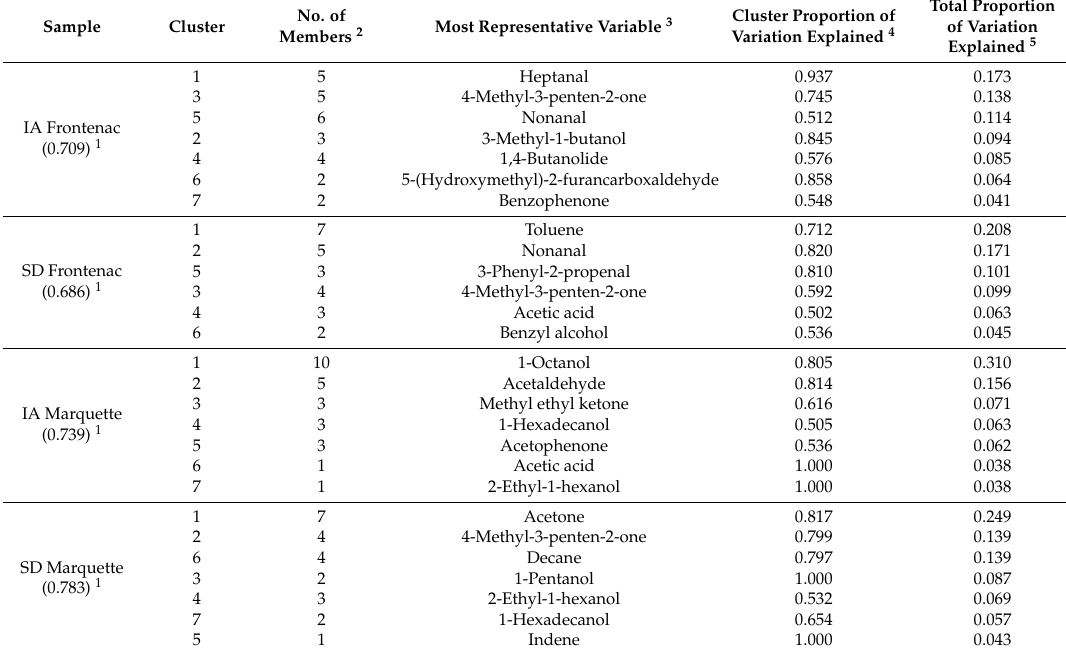
Table 1. Whole cluster analysis. Volatiles emitted from Frontenac and Marquette clusters, grown in Iowa (IA) and South Dakota (SD). These VOCs were indicated to be the most representative variable from hierarchical clustering analysis (HCA) after the PCA (JMP Pro 12.0.1, SAS Institute Inc., Cary, NC,